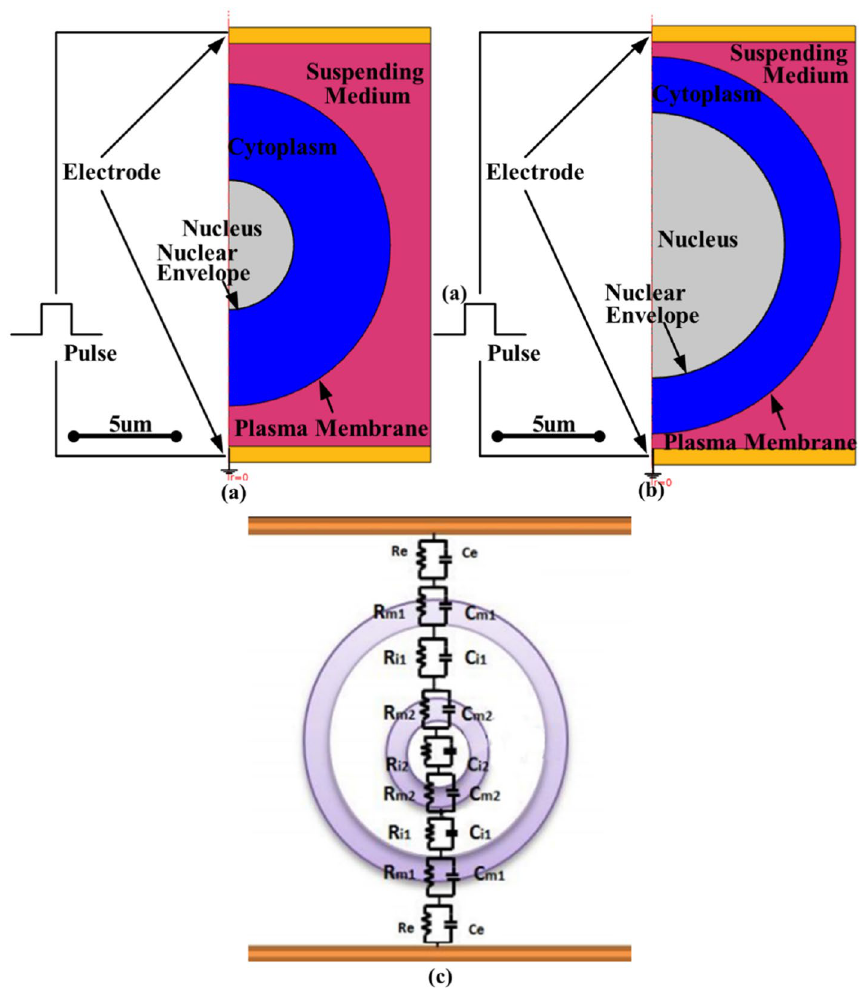
Figure 7. Schematic diagram of the two-dimensional rotating model of the simplified cell suspended in a conductive solution between parallel electrodes. ( a ) normal cell; ( b ) cancerous cell; ( c ) the corresponding circuit